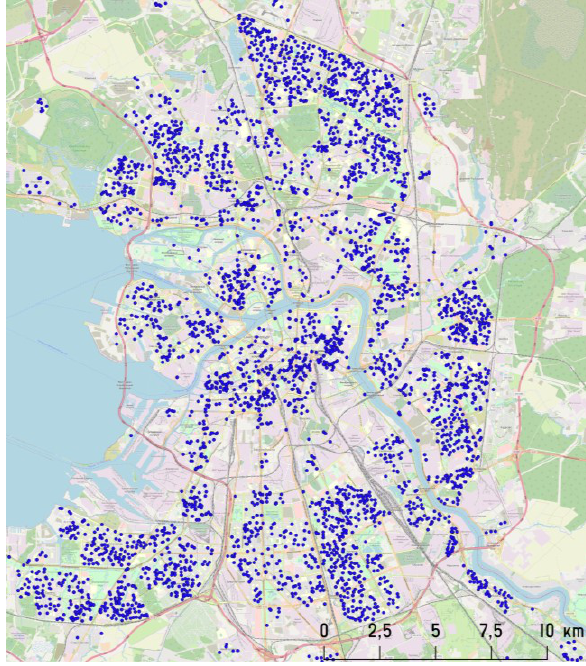
Figure 2. Tuberculosis infection cases observed in the area of